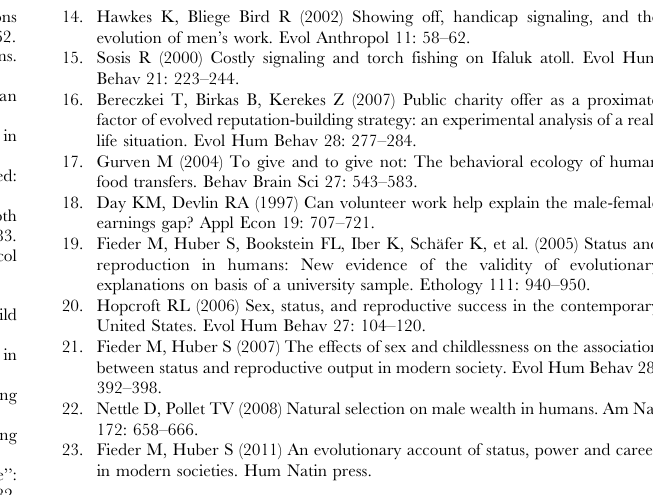
Table S1 Generalized linear model of sex, voluntary work, marital status, education, and income on off- spring number on the basis of a Poisson error structure, including all two-way interactions with voluntary work. Table S2 Generalized linear model of sex, voluntary work, marital status, education, and income on off- spring number on the basis of a Poisson error structure, excluding the least significant interaction from Table S1. Table S3 Generalized linear model of sex, voluntary work, marital status, education, and income on off- spring number on the basis of a Poisson error structure, excluding the least significant interaction from Table